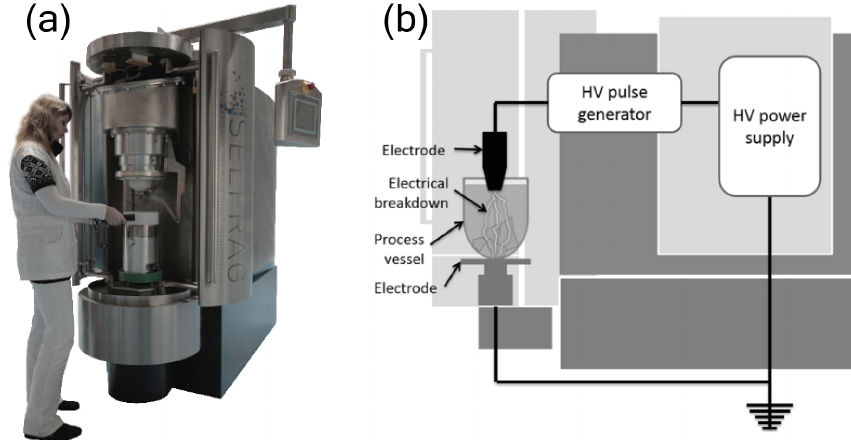
Figure 4. Photograph (a) and schematic (b) of the SELFRAG Lab system (after Bru et al., 2018).